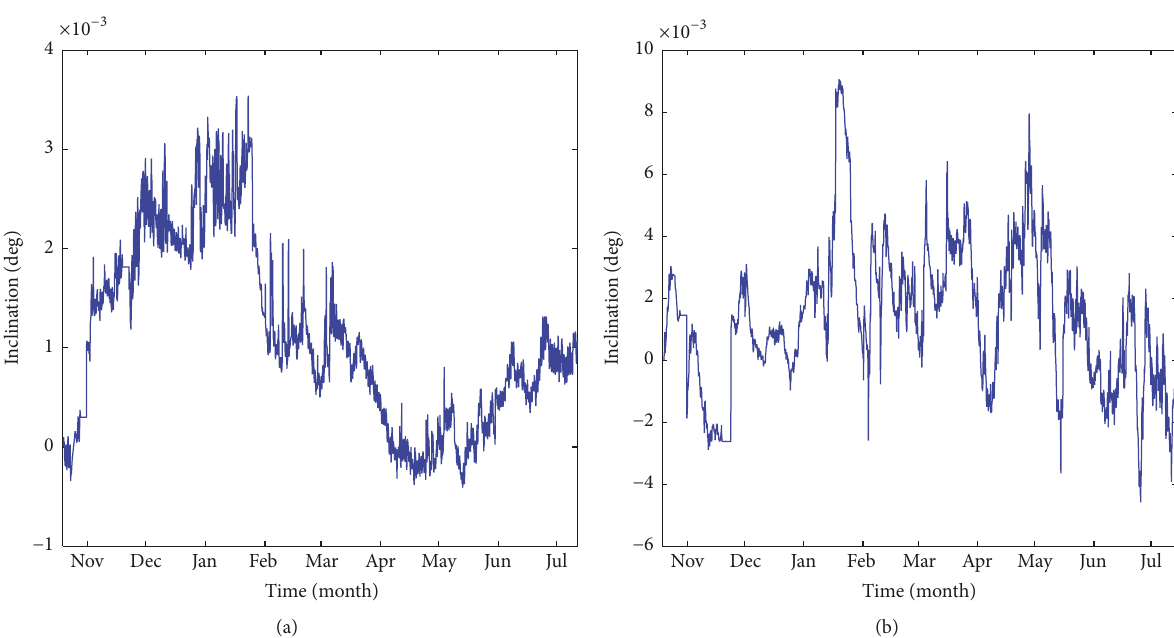
0.3120.3130.3140.3150.316